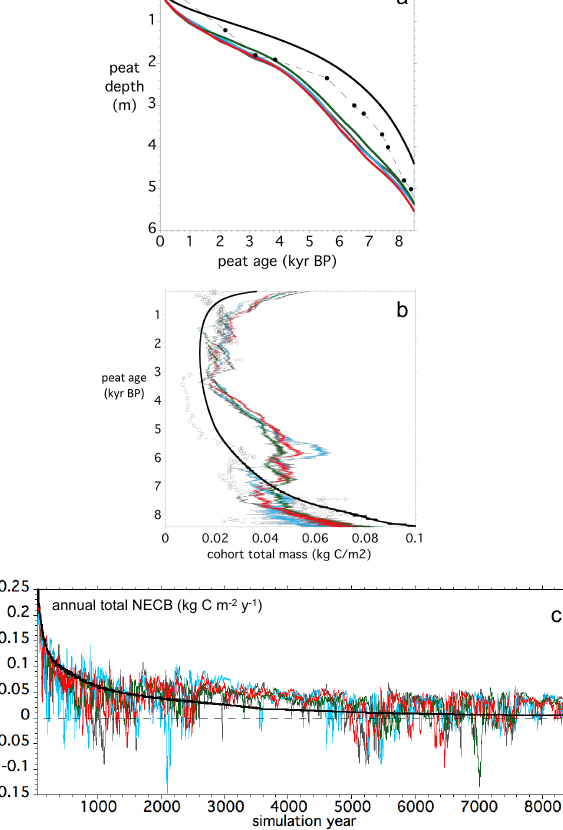
Fig. 5. (a) Simulated age-depth profile of final core (solid lines, colors correspond to those of Fig. 4), and ages determined from core MB930 (solid black circles; Table 3). (b) Simulated final core cohort carbon content (solid lines, colors correspond to those of Fig. 4), and net annual rate of carbon accumulation (NRCA) values from core MB930 (open black circles). (c) HPM simulated annual net carbon balance; this equals total annual NPP (Fig. 4c) minus total annual decomposition (Fig.